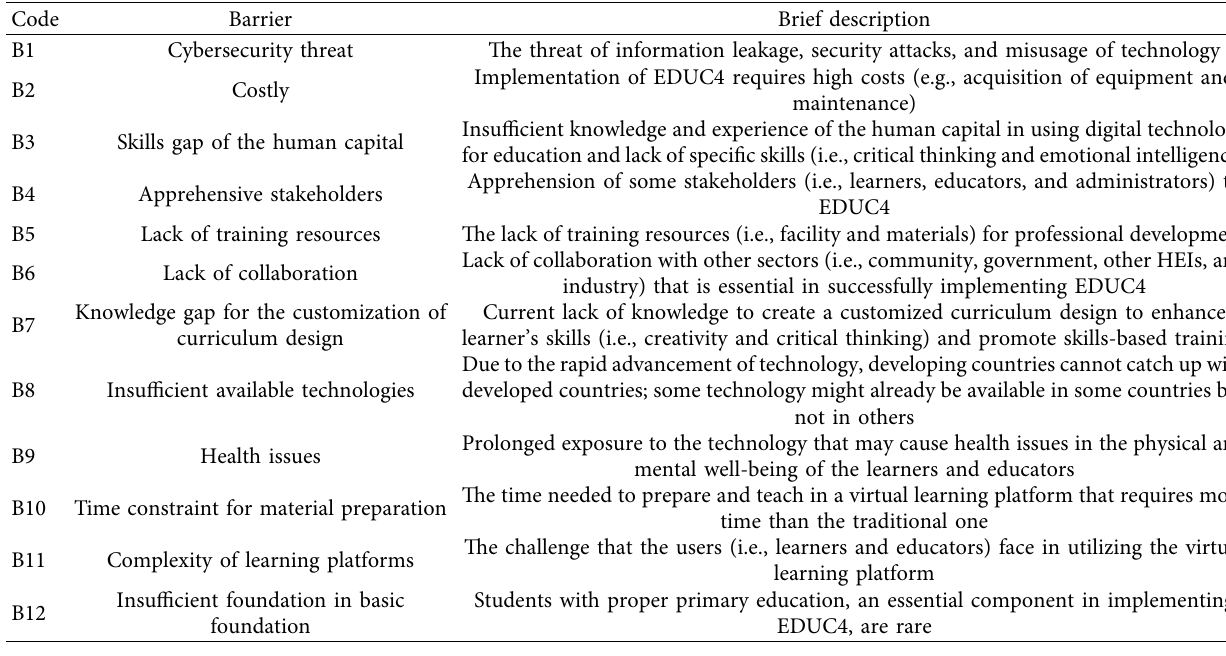
Table 2: Barriers to EDUC4 implementation [7].